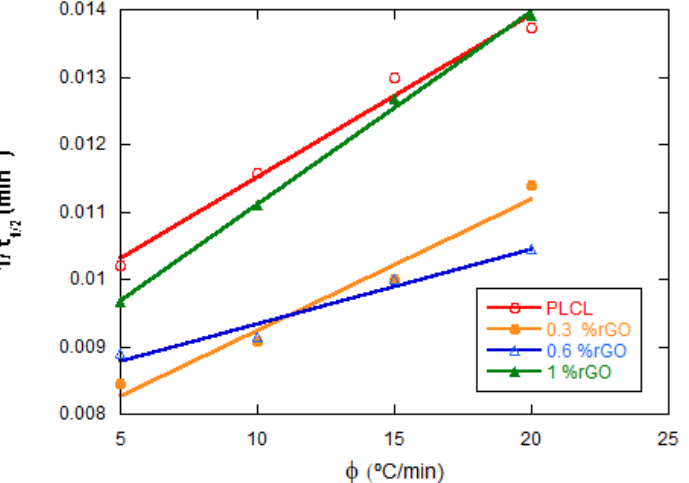
Figure 8. Effect of rGO content on the PLCL crystallization rate for the four compositions studied. Crystallization rate parameter.